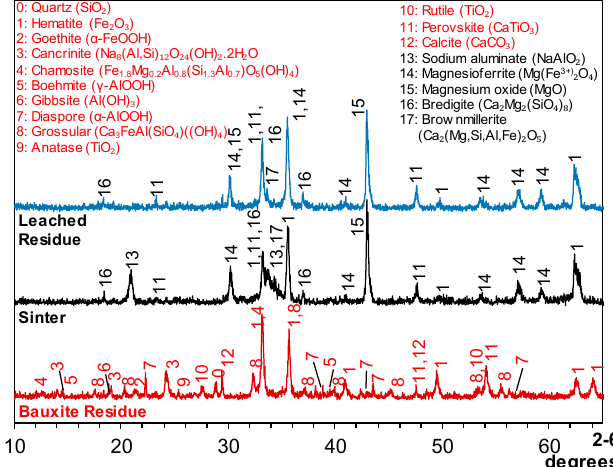
Figure 16. XRD of mineralogical phases for MgO additions (20 g MgO/100 g bauxite residue) at atmospheric conditions at 900 °C and for 2 h. Red font: Existing minerals in bauxite residue; black font: Transformed sinter and leached minerals.